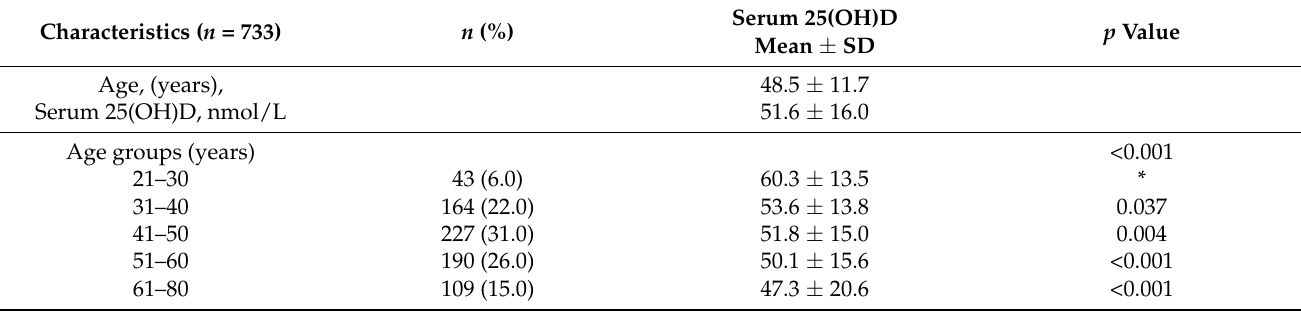
Table 1. Sociodemographic and lifestyle factors by serum 25(OH)D concentration of the study population. Characteristics ( n = 733) n